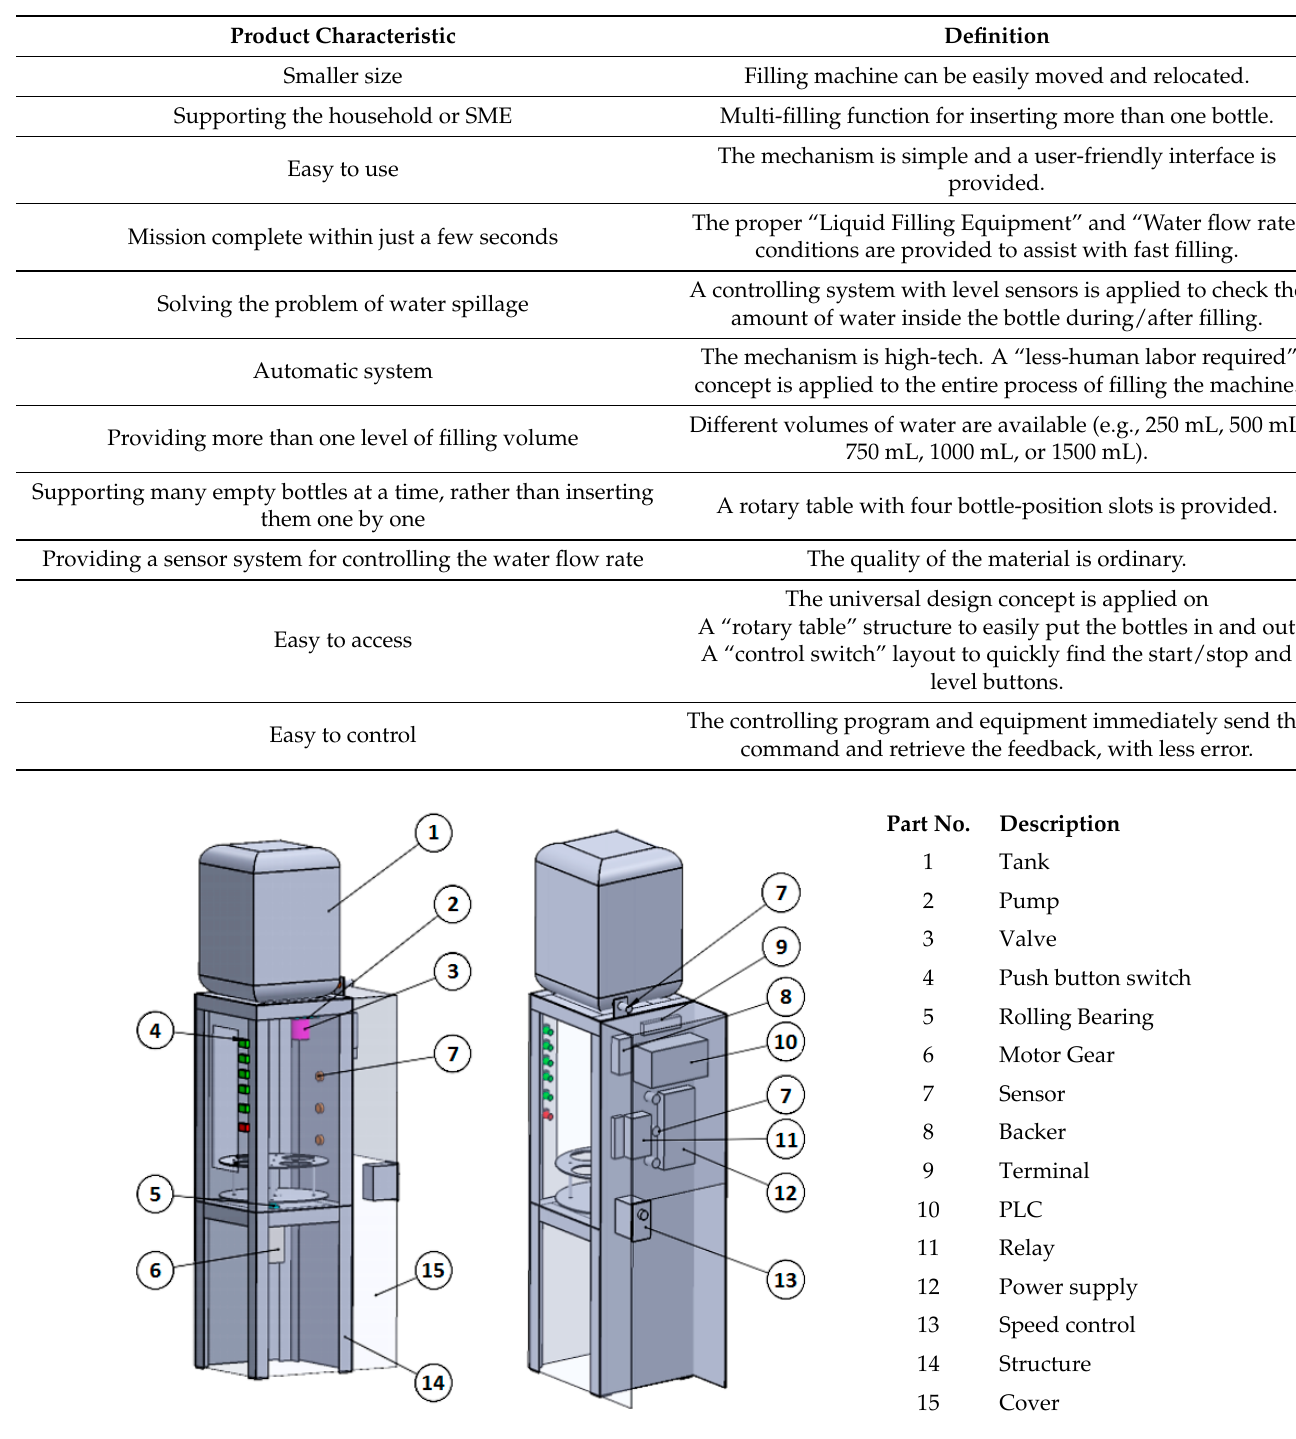
Figure 8. Draft of automatic water filling machine design.